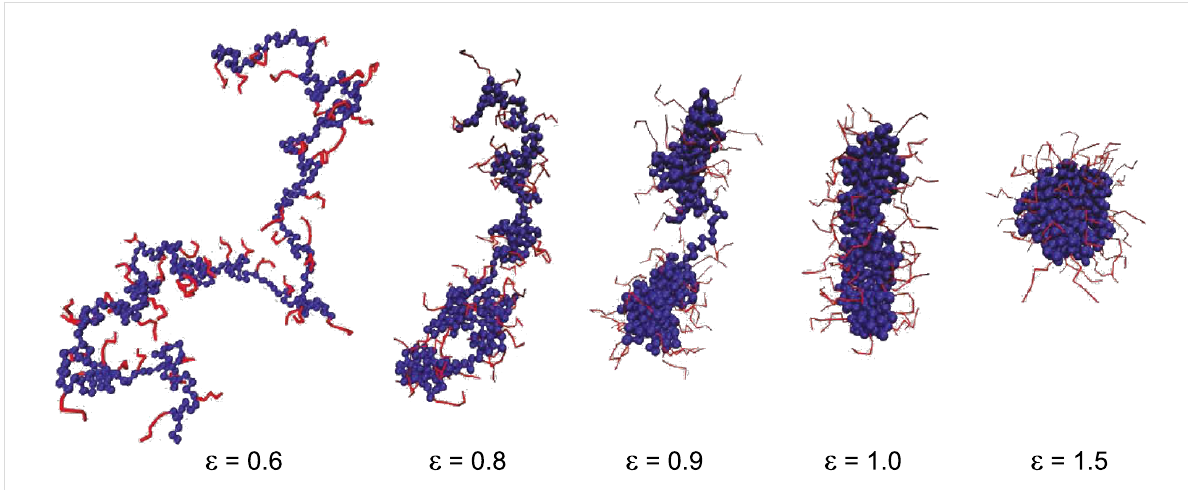
Figure 1: Illustration of the transition from a wormlike structure through a cylindrical micelle down to a spherical micelle, with decreasing solvent quality for the backbone. To make the structure of the backbone clearly visible, the side chains are only drawn as thin lines. Reprinted with permis- sion from Kosovan, P.; Kuldova, J.; Limpouchova, Z.; Prochazka, K.; Zhulina, E. B.; Borisov, O. V. Macromolecules 2009, 42, 6748–6760. Copyright 2009 American Chemical